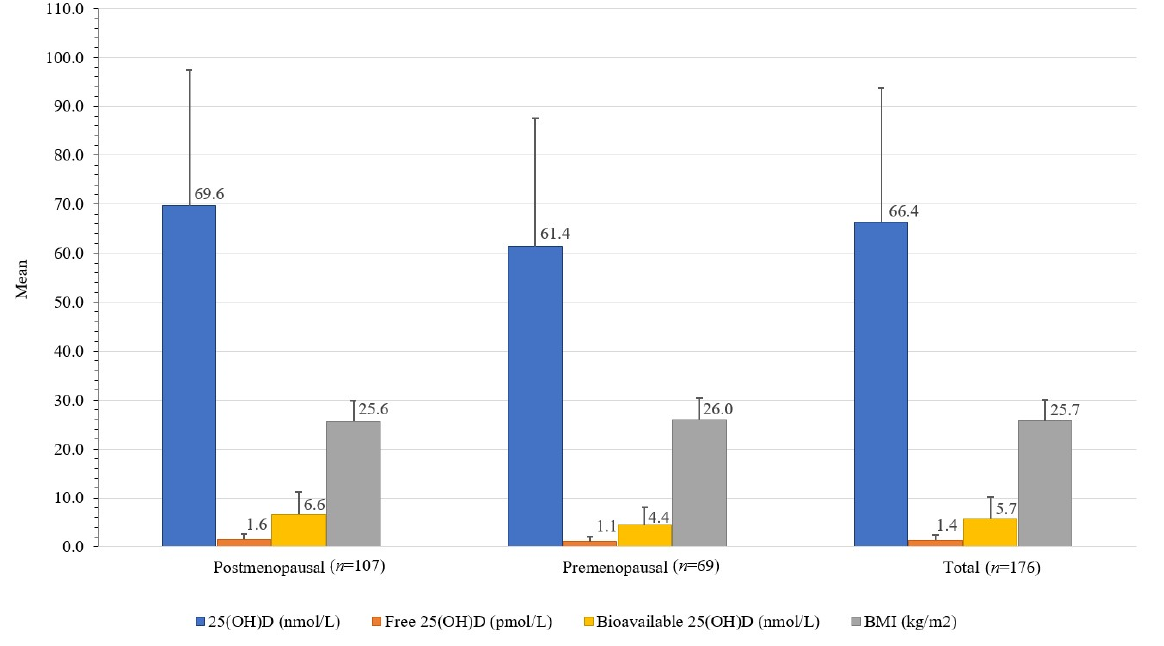
Figure 3. Differences between serum total, free, and bioavailable 25(OH)D concentrations and BMI in healthy women from the Central Slovenia region, aged 44 to 65 years, included in the study carried out between 1 March 2021 and 31 May 2021 ( n = 176).